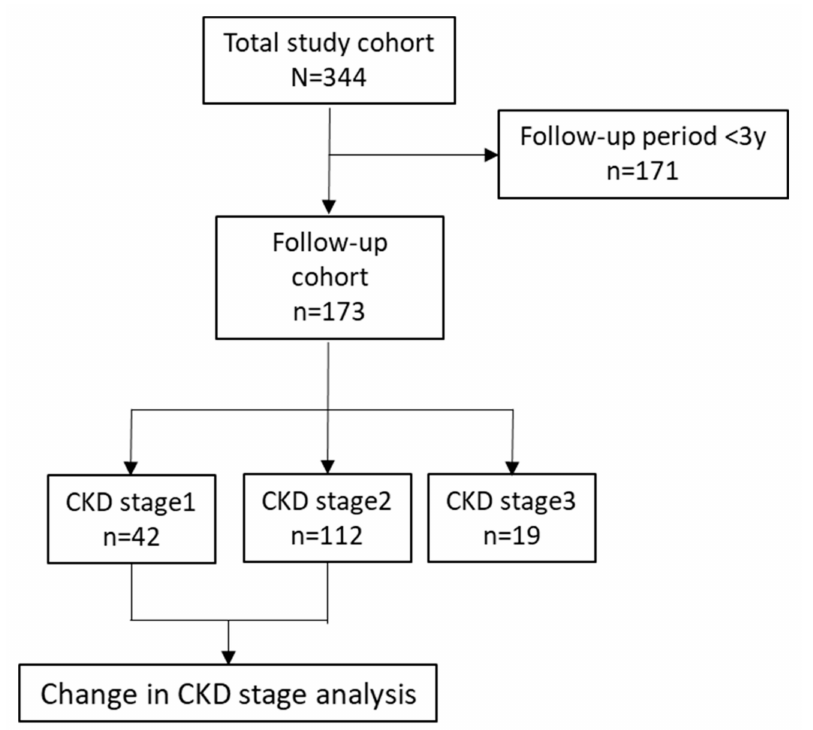
Figure 1. Flow diagram of the enrolled